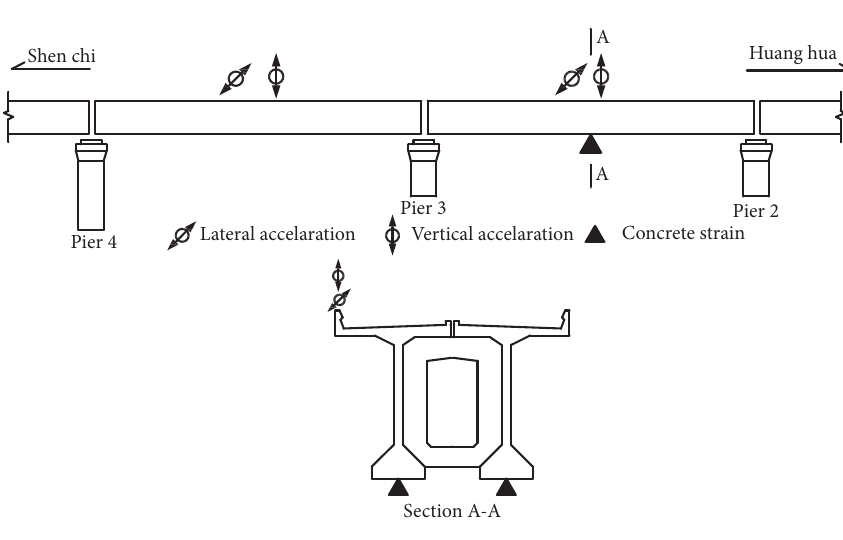
Figure 10: Sensors arranged on the